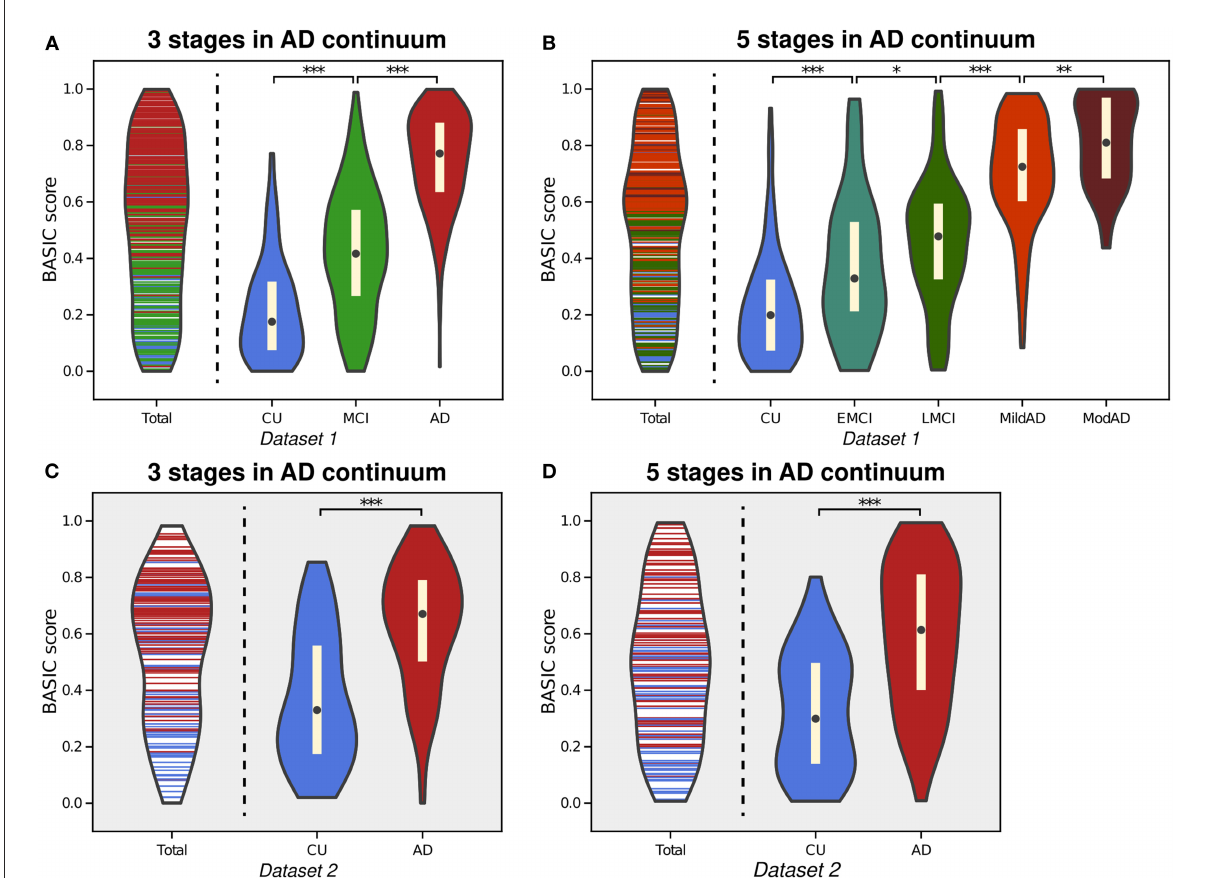
FIGURE3 Violin plot depicting the estimated distributions of BASIC scores of individuals in Dataset 1 in a manner that maximizes the association with disease progression represented by either three stages (A) or five stages (B) in the Alzheimer’s disease (AD) continuum. For external validation, we calculated the scores of people in Dataset 2 using parameters derived from three stages (C) and five stages (D) . * p < 0.05, ** p < 0.01, and *** p < 0.001, with the false discovery rate correction for in each